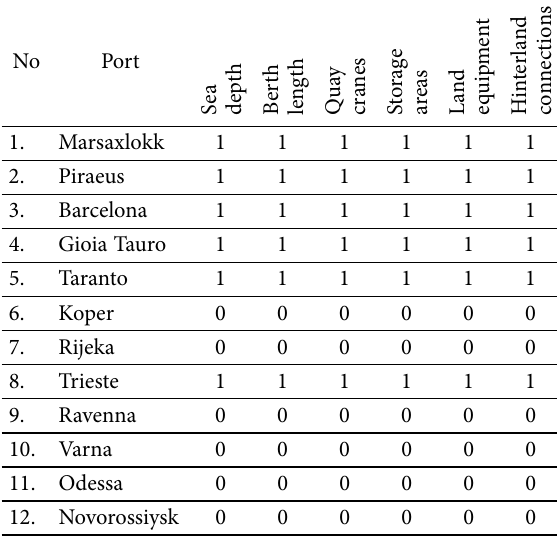
Table 3. Results of the analysis according to the DST (two 6000 TEUs ships in the